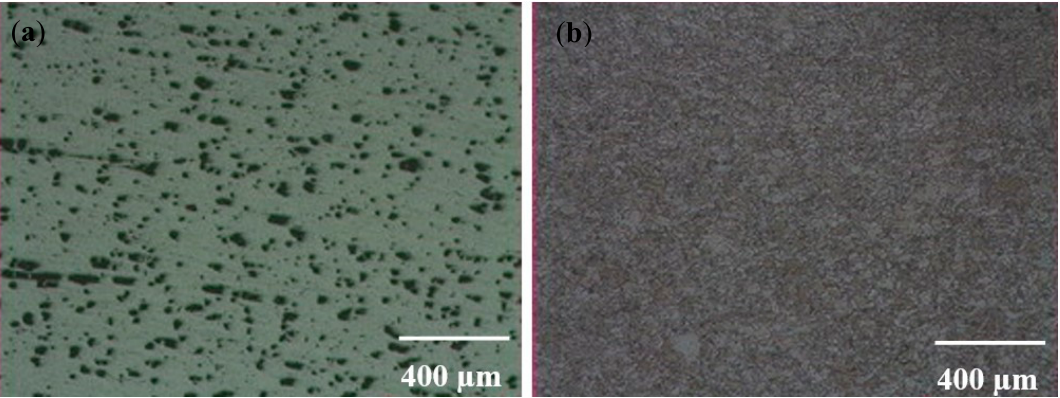
Figure 15. Microstructures of base materials: ( a ) Al-1050; ( b )